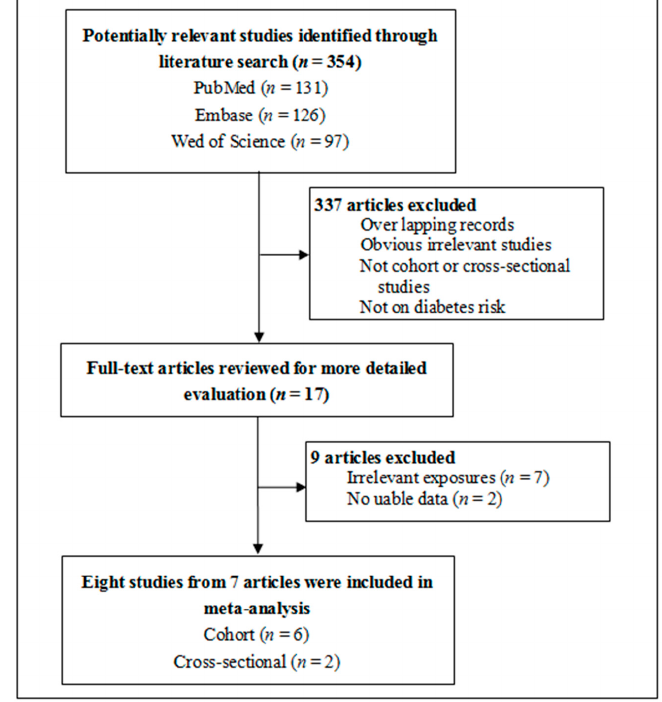
Figure 1. Flow chart of study selection in this meta-analysis.